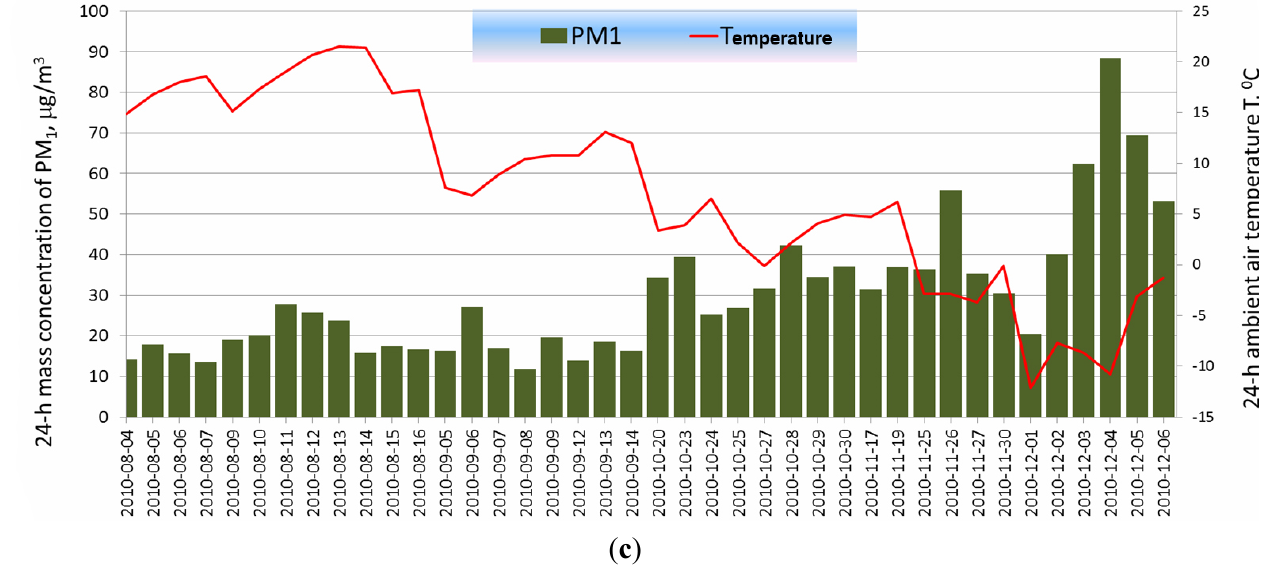
Figure 1. 24-h mass concentrations of PM 1 at regional background site, RB ( a ) at urban background site, UB ( b ) and at urban traffic site, UT ( c